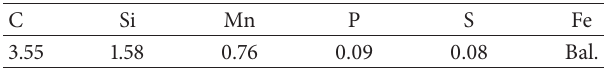
Figure 3: Microstructure of HT250 substrate. Table 2: Chemical compositions of HT250 (wt.%).